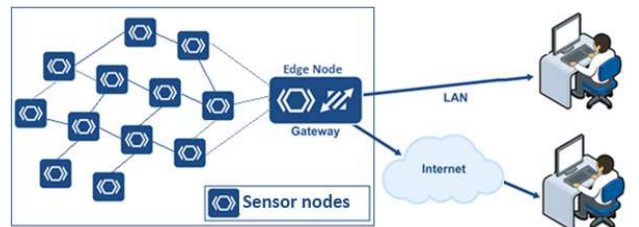
Figure 3. WSN connected to local infrastructure and internet